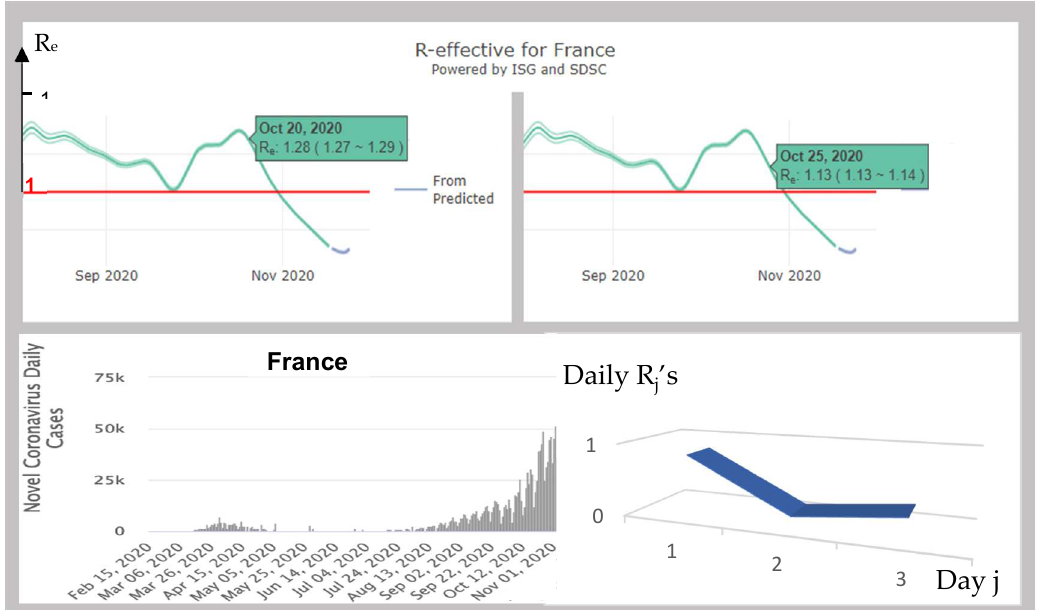
Figure 3. Top : estimation of the effective reproduction number R e ’s for 20 October and the 25 October 2020 (in green, with their 95% confidence interval) [28,29]. Bottom left : daily new cases in France between 15 February and 27 October [30]. Bottom right : U-shape of the evolution of the daily R j ’s along the 3-day contagiousness period of an